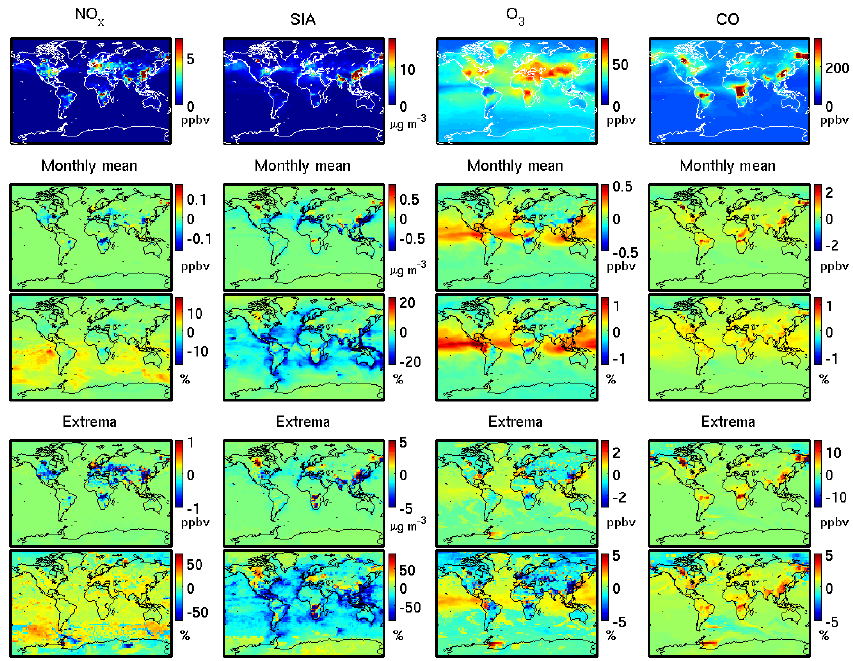
Figure 5. Effect on simulated species of changing from the GEOS-Chem traditional operator durations (C30T15) to the shortest operator du- rations considered (C10T05). The top row contains monthly mean ground-level concentrations simulated with the C30T15 operator duration at 2 ◦ × 2.5 ◦ horizontal resolution. The next two rows contain the monthly mean differences (C30T15 minus C10T05) for absolute (second row) and relative (third row) differences. The two lowest rows contain the maximum differences (C30T15 minus C10T05) for absolute (fourth row) and relative (bottom row) differences. Each column from left to right represents nitrogen oxides (NO x ), secondary inorganic aerosols (SIA), ozone (O 3 ), and carbon monoxide